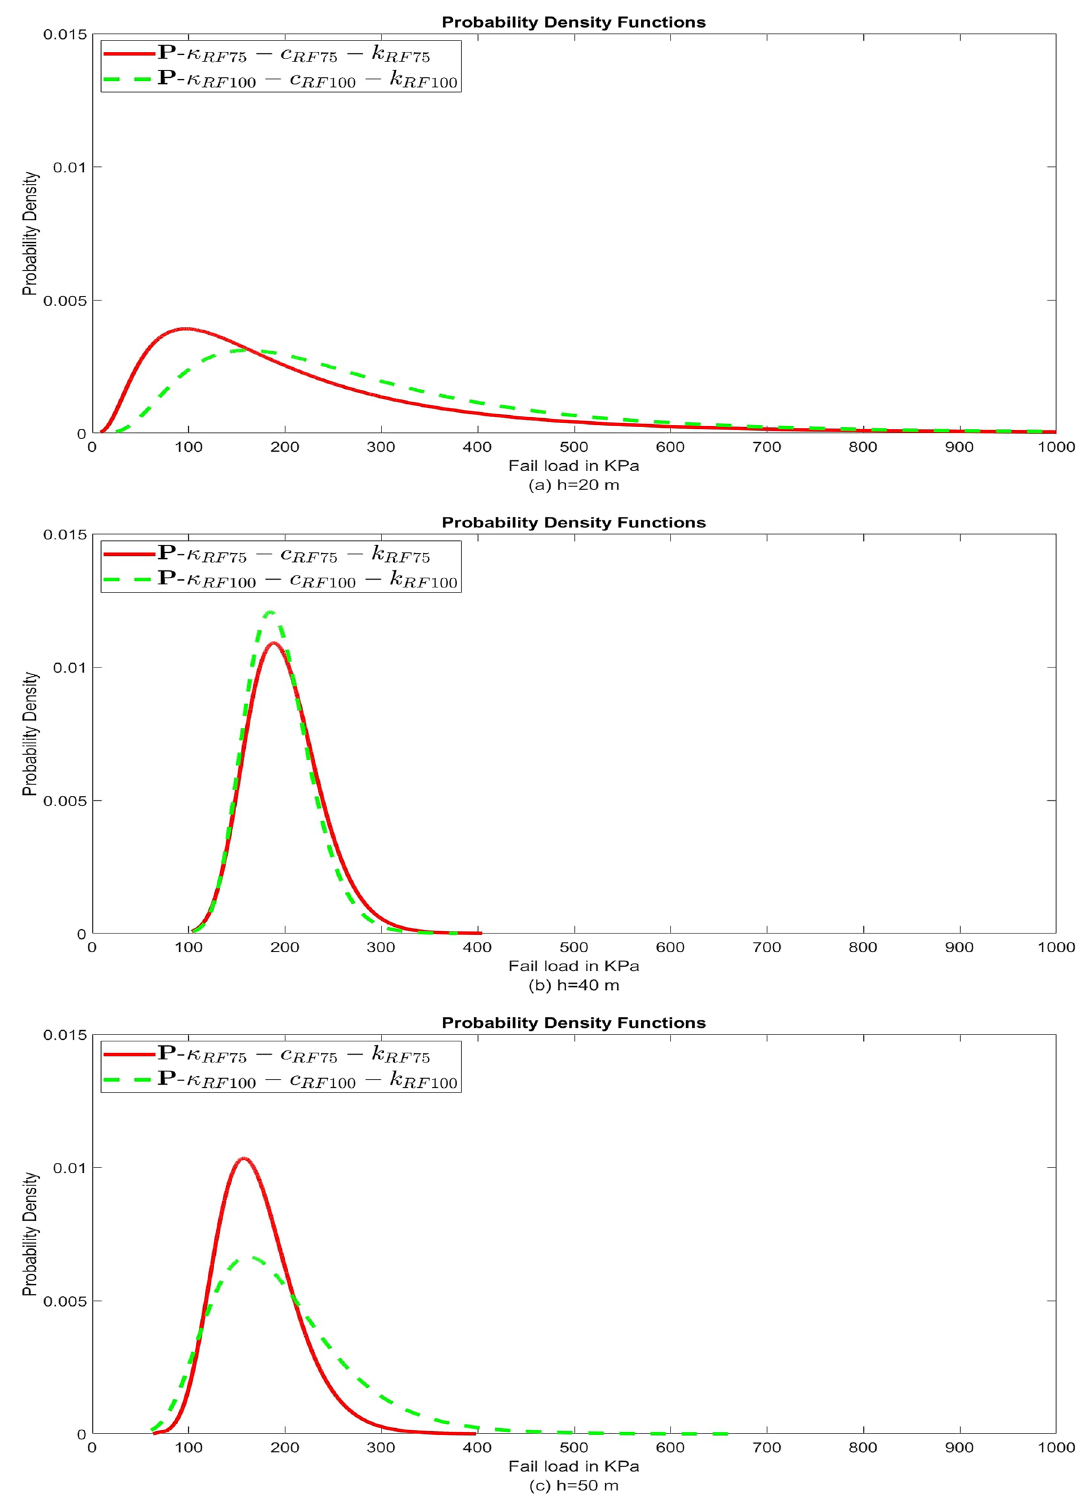
Fig. 11 PDFs of failure load of porous analyses with random field representation for all stochastic material